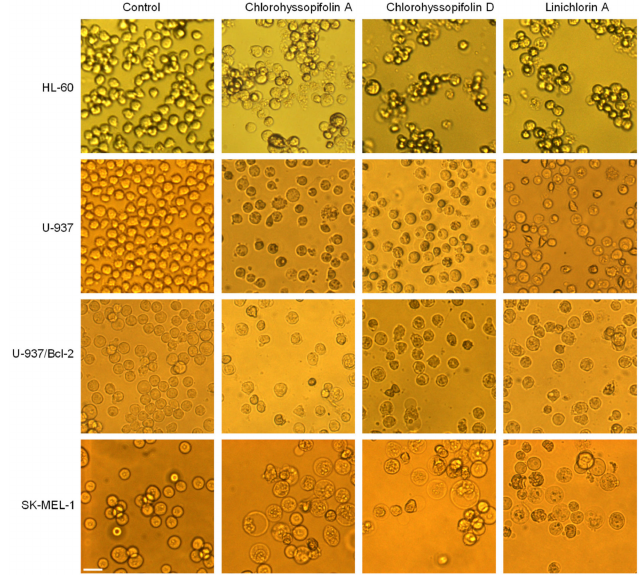
Figure 2. Cells were incubated with dimethylsulfoxide (DMSO) (control) or 10 µ M of the compounds shown at the top of the figure for 24 h and images were obtained with an inverted phase-contrast microscope. Original magnification 20 × . Bar represents 10 µ